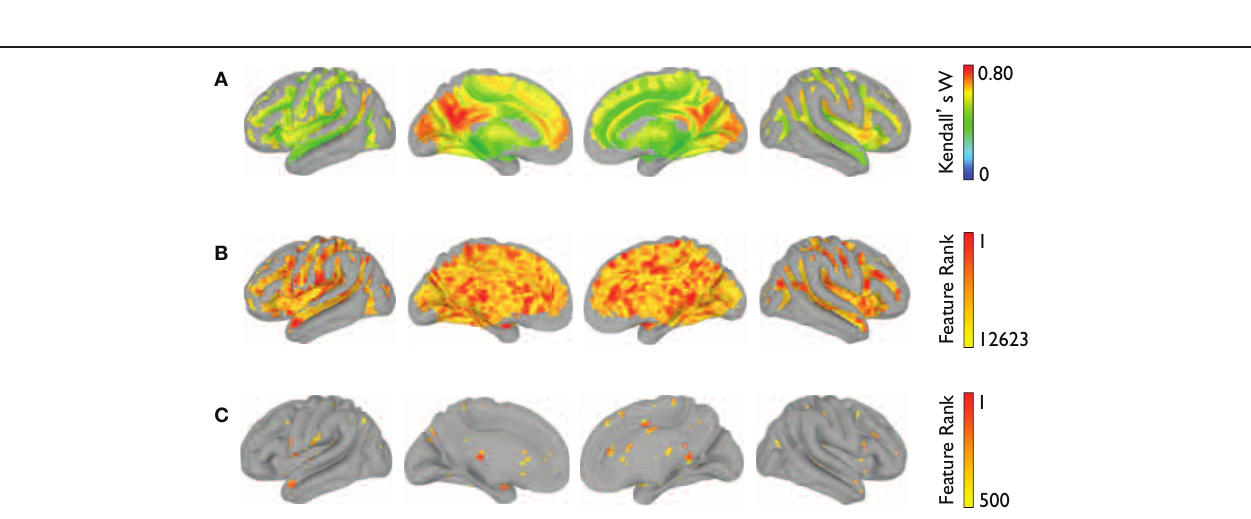
FIGURE 9 | Global connectivity feature rankings(NYU site). For each voxel present in all participants (across all sites), (A) the group-averaged correlation with every other voxel, (B) the average feature rankings from the within-site classification, and (C) the top 500 features from the within-site classification are shown.